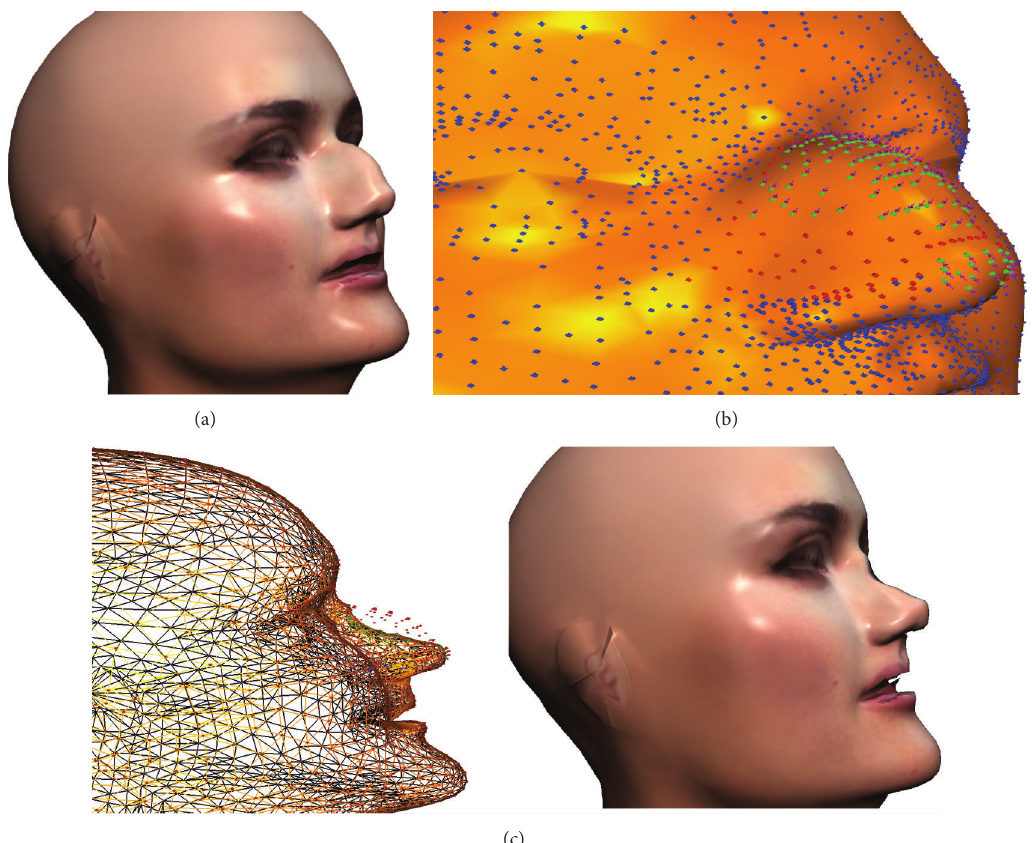
Figure 12: (a) Initial misshapen nose. (b) The head mesh is constrained at the blue nodes and pushed upwards at the green nodes. (c) The result of the nonlinear FEM: left: wireframe surface mesh with nodes; right: shaded mesh with texture.